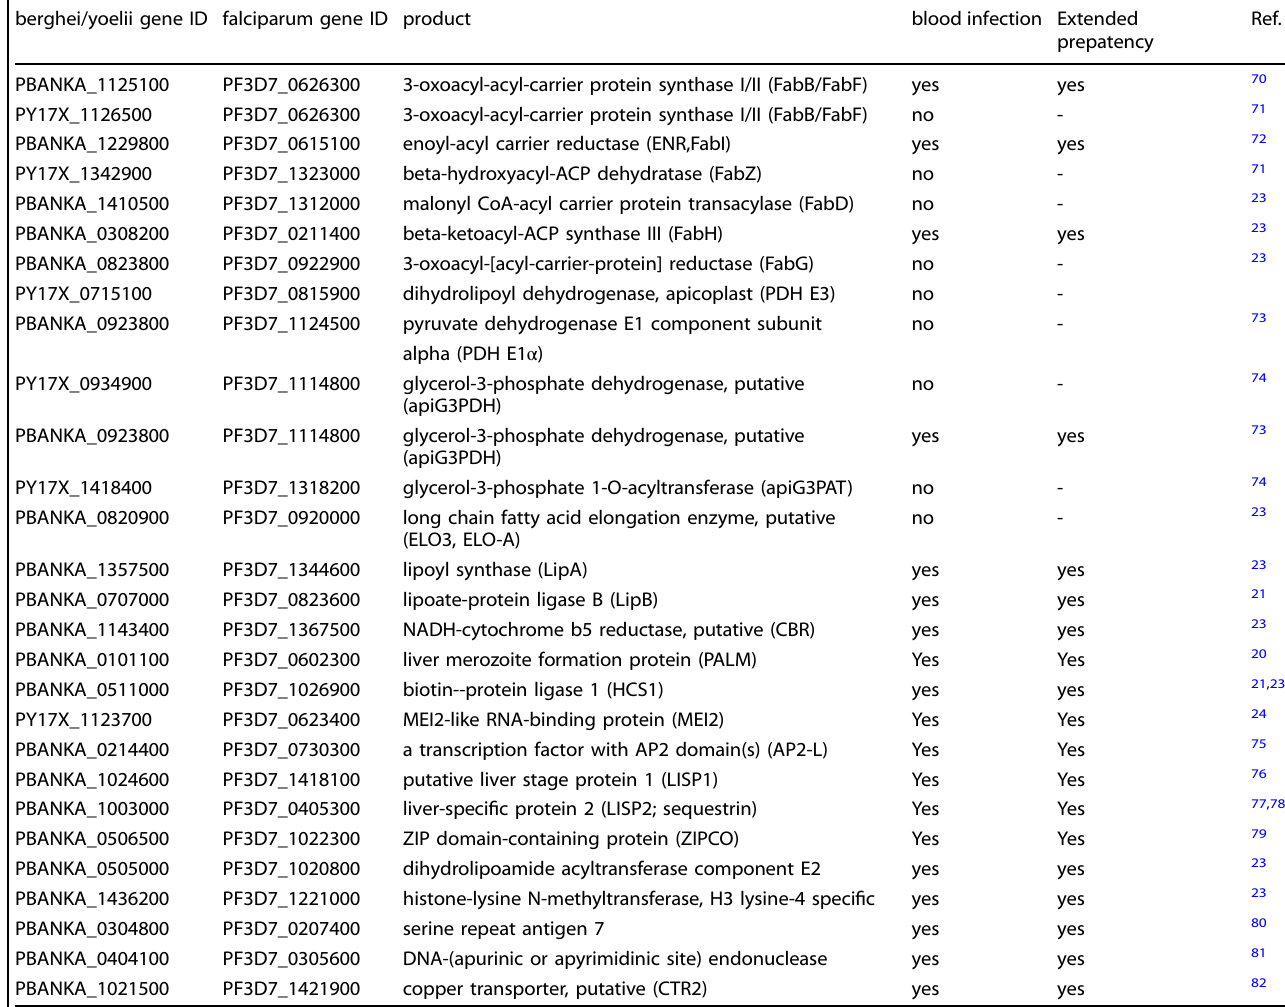
Table 1. Published rodent malaria gene-deletion mutants with a ‘ late-liver stage ’ growth phenotype. berghei/yoelii gene ID falciparum gene ID product blood infection Extended